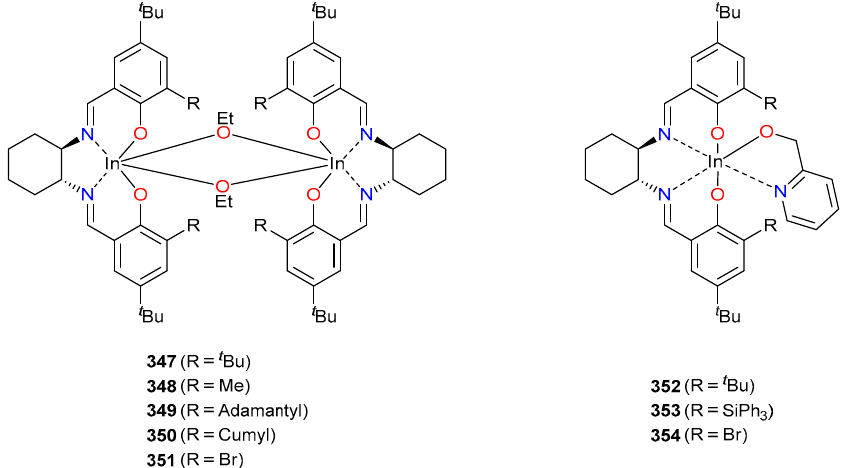
Figure 53. Salen-In catalysts for the isoselective ROP of rac -Lactide [145,146].